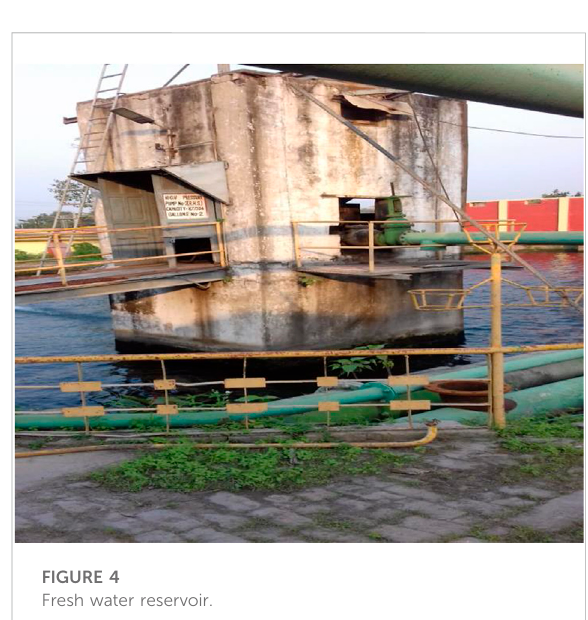
FIGURE 4 Fresh water